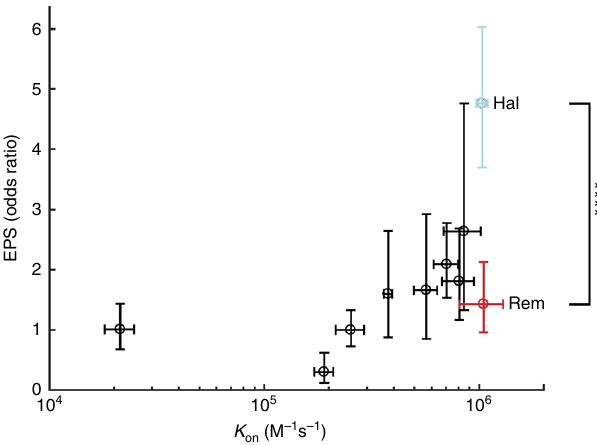
Fig. 1 Correlation plot showing the relationship between k on (from Sahlholm et al. 2 ) and EPS odds ratio (from Leucht et al. 8 and Lewander et al. 3 ). The plotted antipsychotics are, from left to right: quetiapine, clozapine, olanzapine, amisulpride, asenapine, risperidone, paliperidone, chlorpromazine, haloperidol (Hal; turquoise), and remoxipride (Rem; red). **** p < 0.0001; p value calculated using Fisher ’ s exact test on the basis of data from Lewander et al. 3 Vertical error bars represent credible intervals for the EPS odds ratios from the Bayesian hierarchical model by Leucht et al. 8 (212 studies including 43049 patients), except for remoxipride, where the error bars represent a con fi dence interval calculated by extending the dataset of Leucht et al. 8 , by incorporating data from Lewander et al. 3 (437 patients receiving haloperidol and 667 patients receiving remoxipride), as described in Methods. Horizontal error bars represent S.E.M. of the k on estimates (based on data from 9 to 30 oocytes for each antipsychotic) and re fl ect the uncertainty of the linear regression of data from Sahlholm et al.